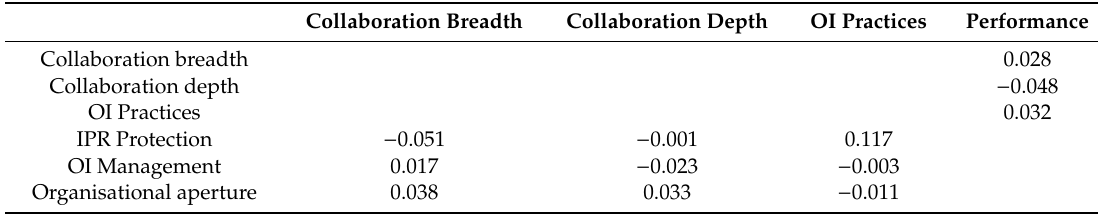
Table 17. Predictive capacity e ff ect size ( q 2